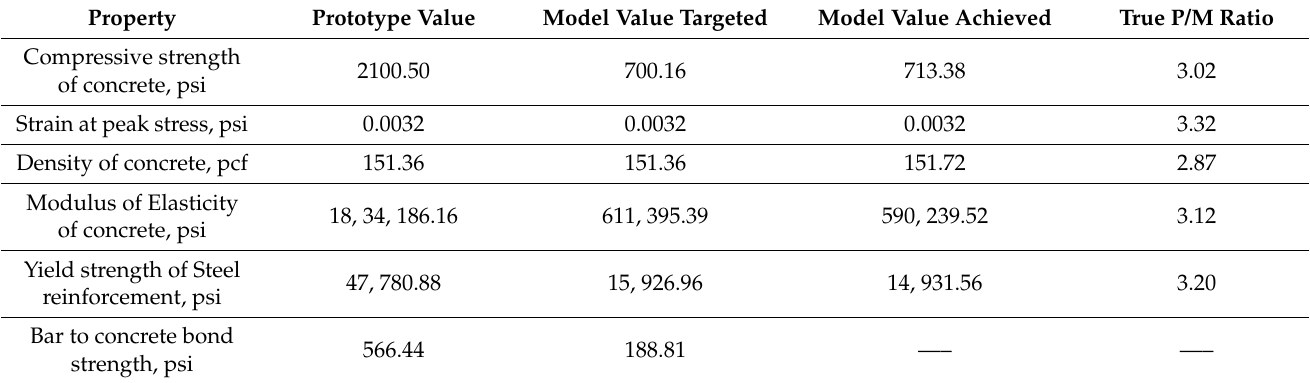
Table 1. Concrete and reinforcement material properties of infilled and confined masonry wall models.